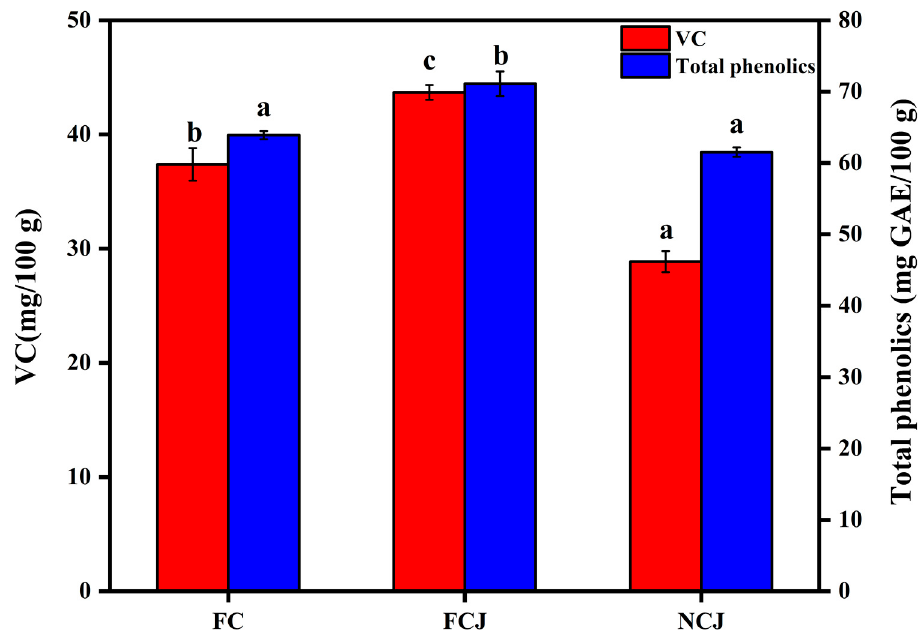
Figure 1. Contents of vitamin C (VC) and total phenolics in fresh citrus (FC), fresh citrus juice (FCJ), and not-from-concentrate citrus juice (NCJ). Gallic acid equivalents (GAE). Different lowercase letters indicate significant differences, p < 0.05.